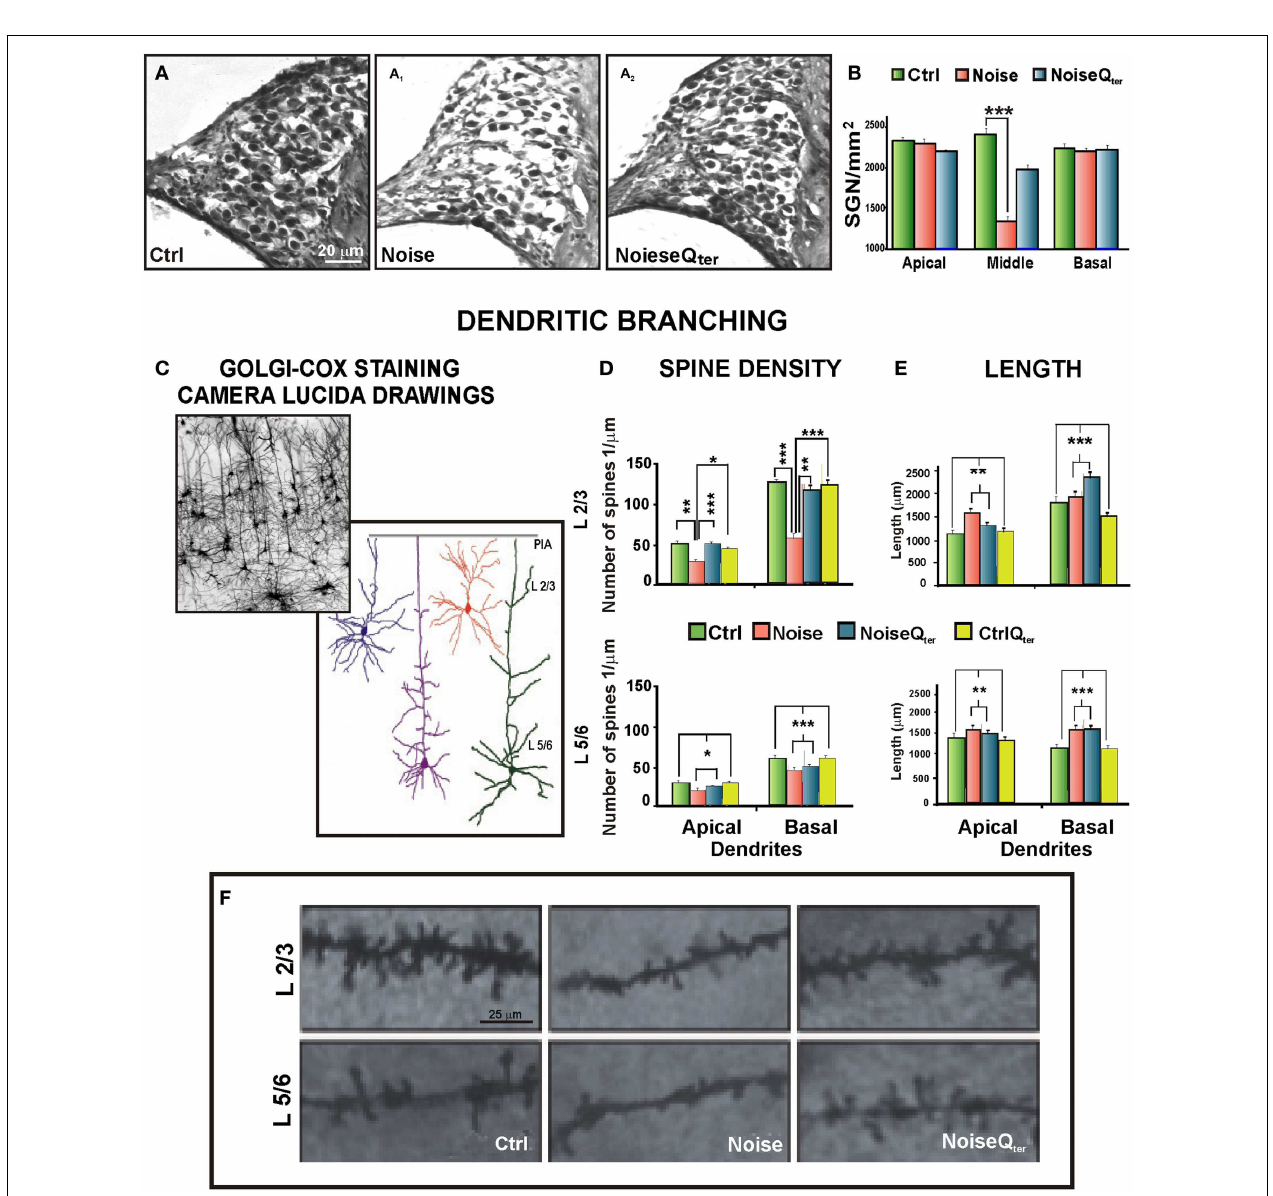
antioxidant treatment (Q ter ) on dendritic spine density and length of L 2/3 (above) and L 5/6 (below) pyramidal neurons.Vertical bars indicate SEM, * p < 0.05, ** p < 0.001, *** p < 0.0001. (D) The acoustic trauma significantly decreases spine density in the apical and basal dendrites of both cortical layers. Q ter treatment rescues control values of spine density for both apical and basal dendrites in L 2/3 but not in L 5/6. (E) In both layers, the acoustic trauma significantly increases neuronal length both in apical and basal dendrites. Q ter treatment does not modify the dendritic length enhanced by the acoustic trauma in the apical and basal arborizations of L 2/3 and L 5/6 pyramidal neurons. (F) Photomicrographs visualize the spines of apical dendritic segments of pyramidal neurons belonging to L 2/3 and L 5/6 of the auditory cortex. Data are adapted from Fetoni et al. (2013).